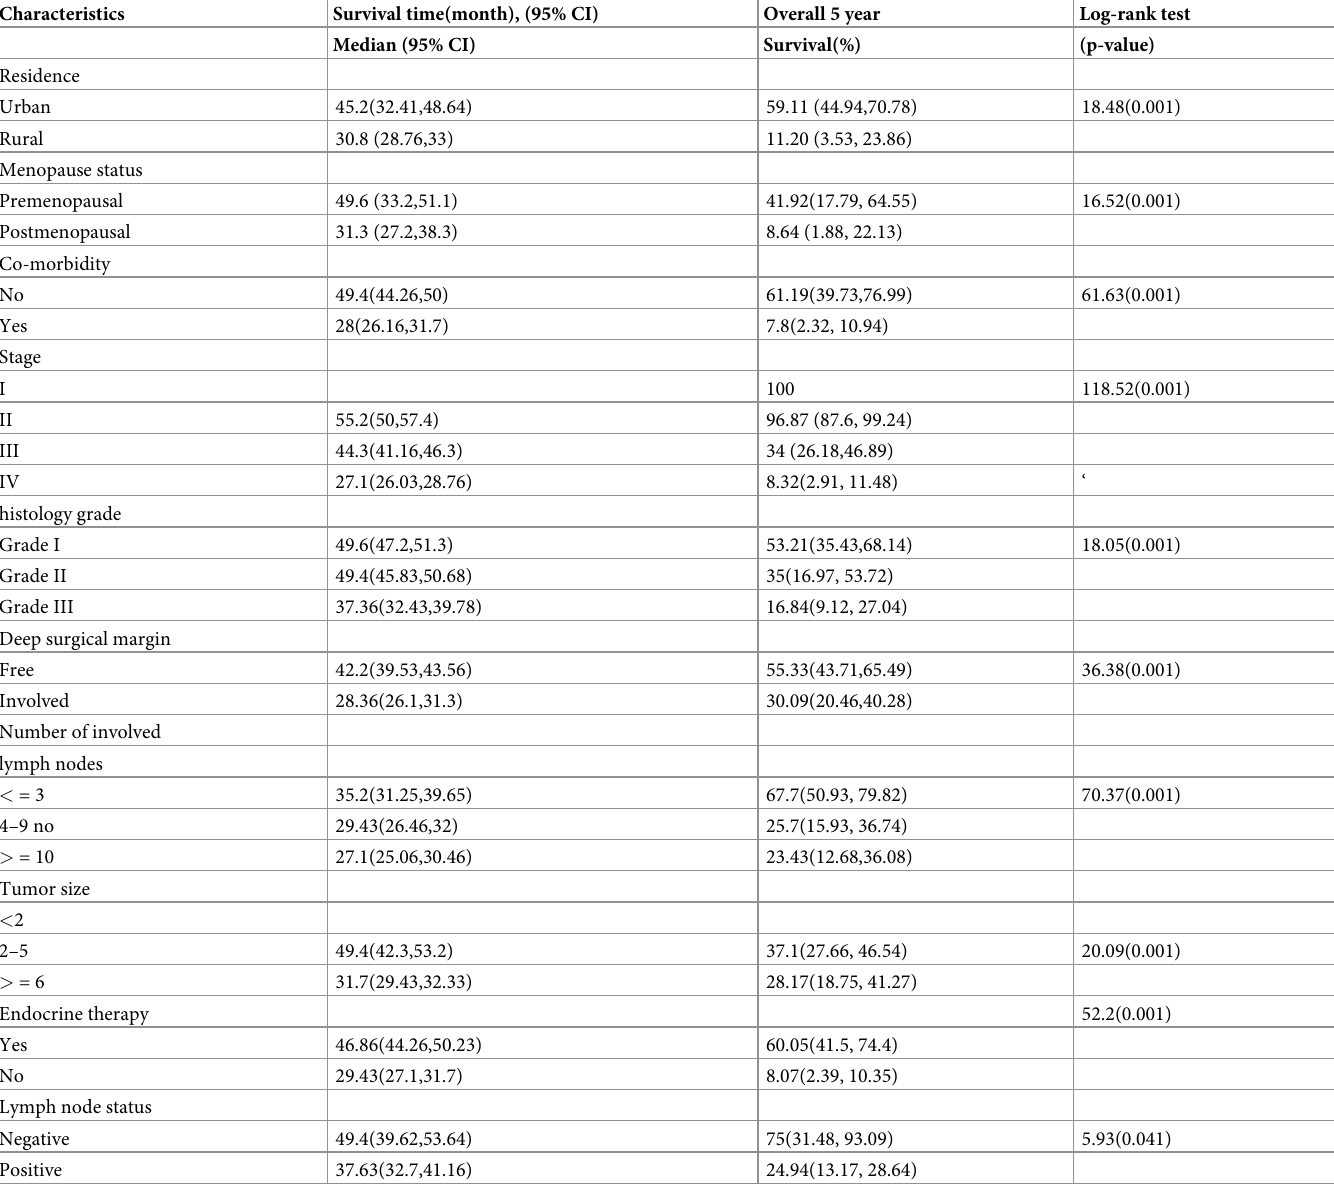
Table 3. Median survival time and log- rank test for the study population based on different characteristics of patients during 5-year of follow-up of breast cancer patients at, UOGCSRH.